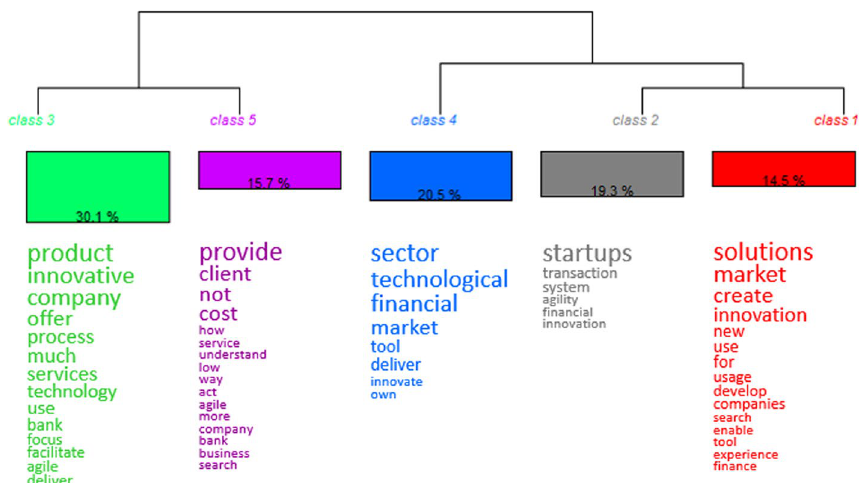
Fig. 5 Dendrogram of